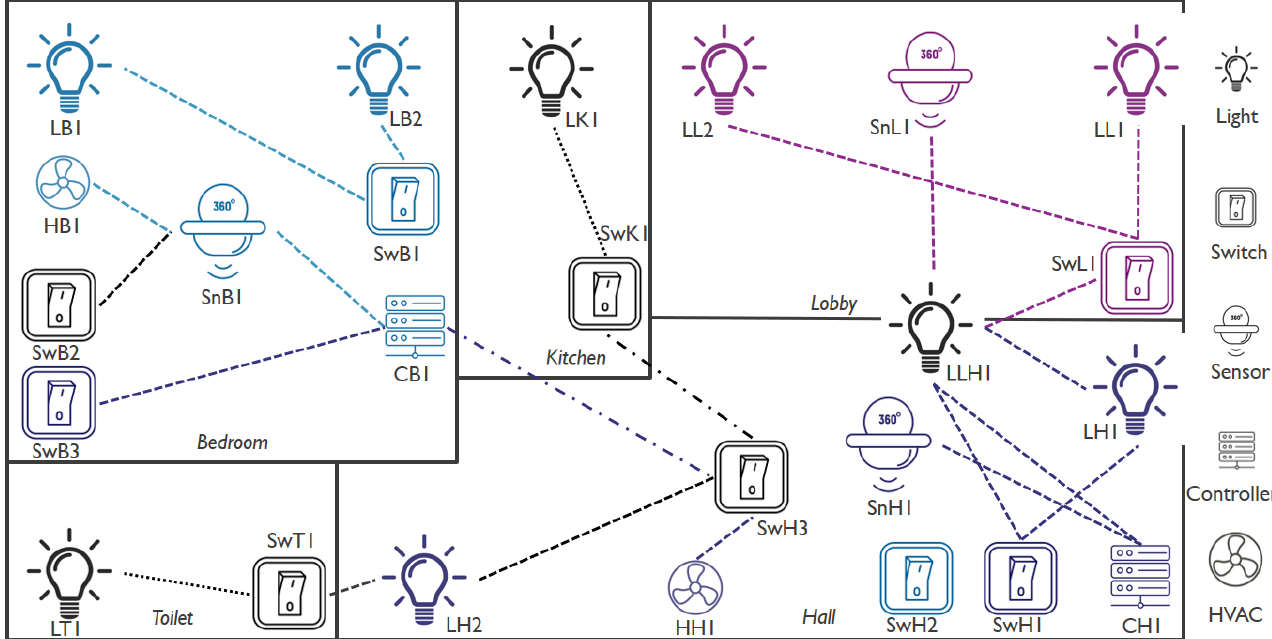
Figure 1. An example scenario of a heterogeneous BLE mesh network, where smart lighting mesh nodes act as a backbone for a HVAC